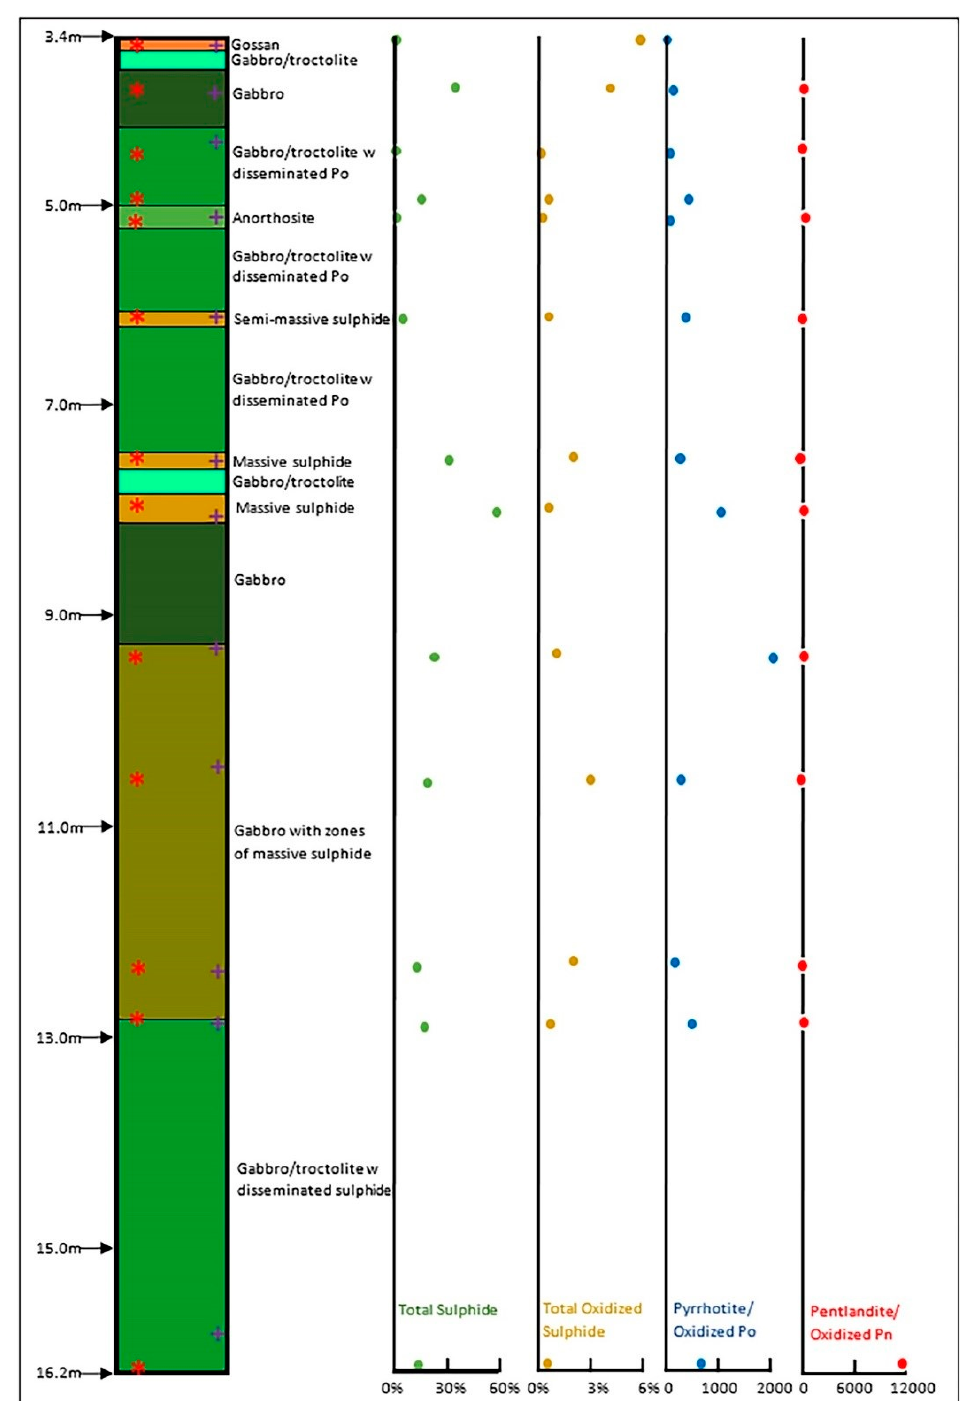
Figure 2. Drill log of hole VB95-129 with location of MLA samples (*) and geochemical samples (+) and downhole plots of mineral contents and ratios as mapped by MLA-SEM; Po = pyrrhotite and Pn =